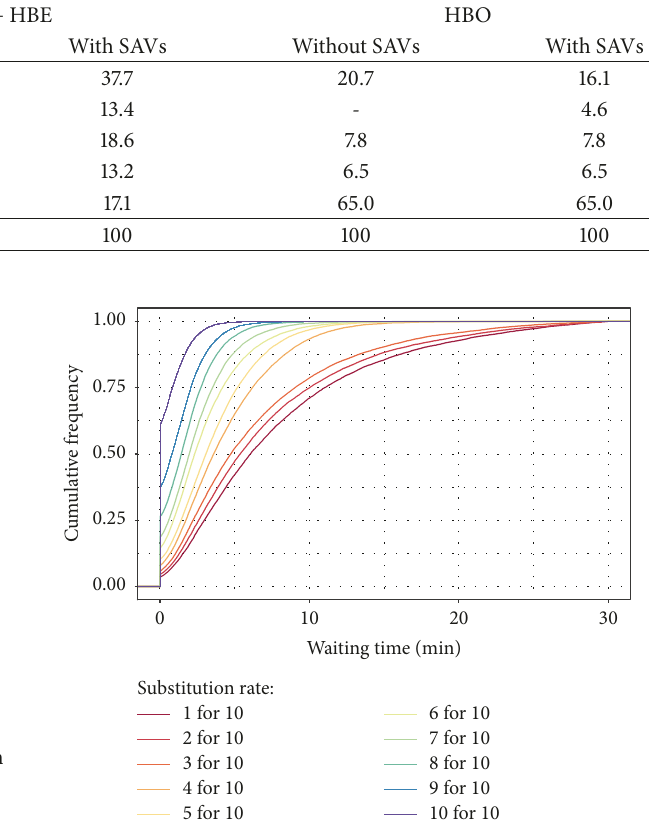
Figure 5: Waiting time cumulative distribution function by substi- tution